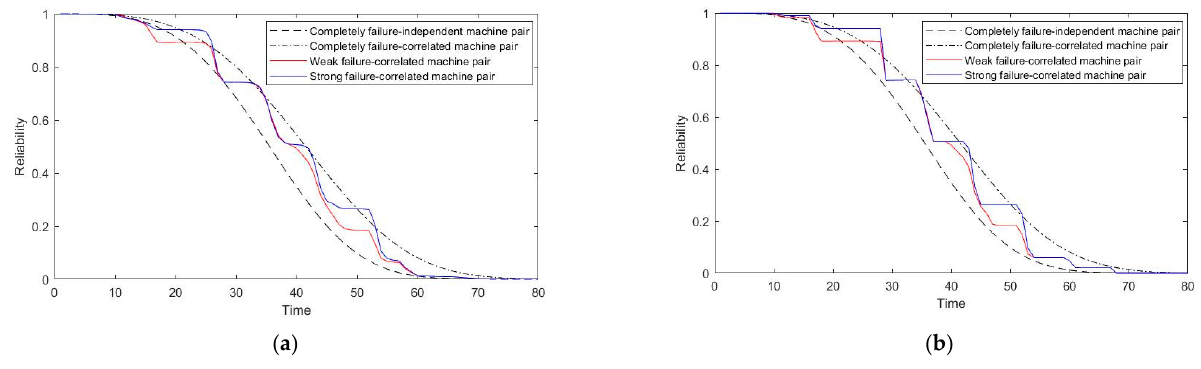
Figure 10. Subsystem reliability evaluation of Machine pair 7–8: ( a ) Gaussian membership function and double Gaussian membership function selected; ( b ) triangular membership function and trapezoid membership function selected.